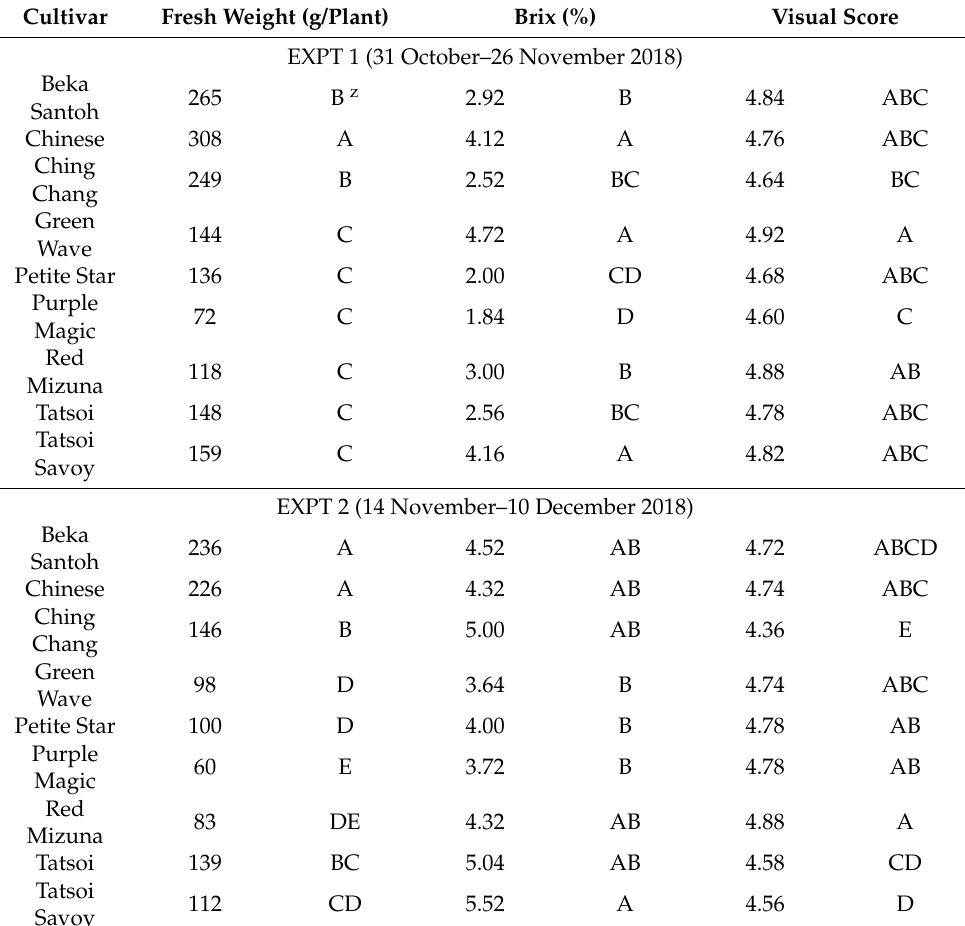
Table 3. Yield (fresh shoot weight), leaf Brix, and visual scores of leafy vegetables grown in containers in a greenhouse in El Paso, TX,